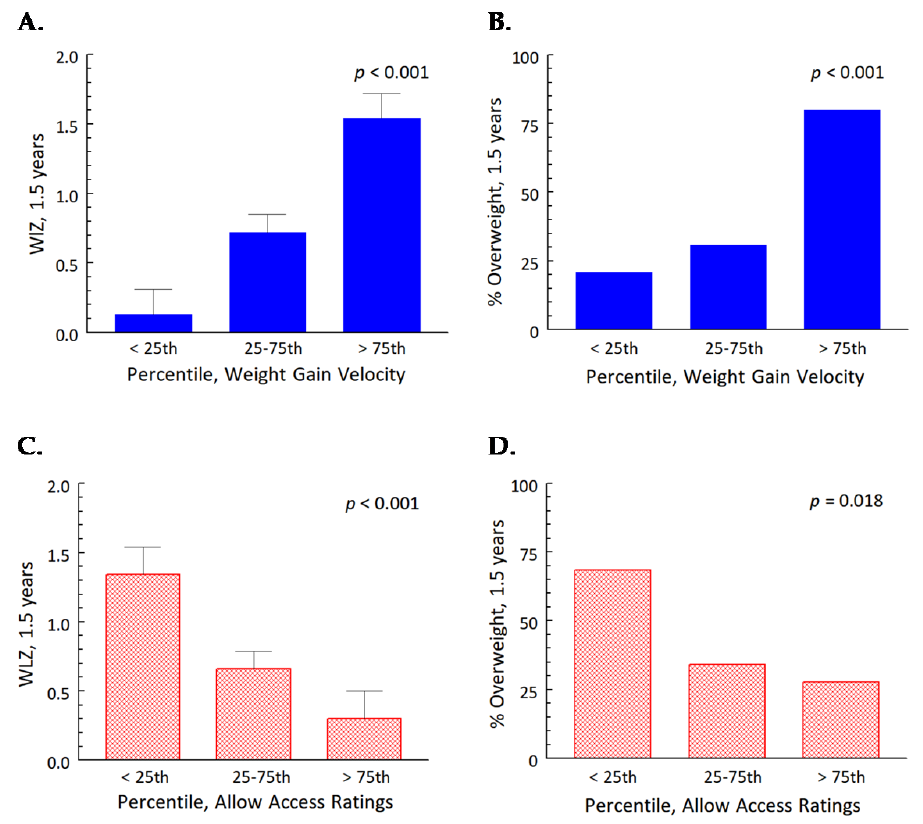
Figure 2. WLZ scores of toddlers and percent overweight at 1.5 years ( n = 78) by percentile category of early weight gain velocity (g/day) from 0.5 to 4.5 months (blue bars) and maternal Allow Access ratings at 1 and 1.5 years (red hatched bars). Higher velocities in weight gain (>75th percentiles) were associated with higher WLZ scores ( A ) and a greater proportion of toddlers with overweight at 1.5 years, ( B ) whereas higher ratings by mothers for allowing their toddlers access to snacks and sweets were associated with lower WLZ scores ( C ) and a smaller proportion with overweight at 1.5 years ( D